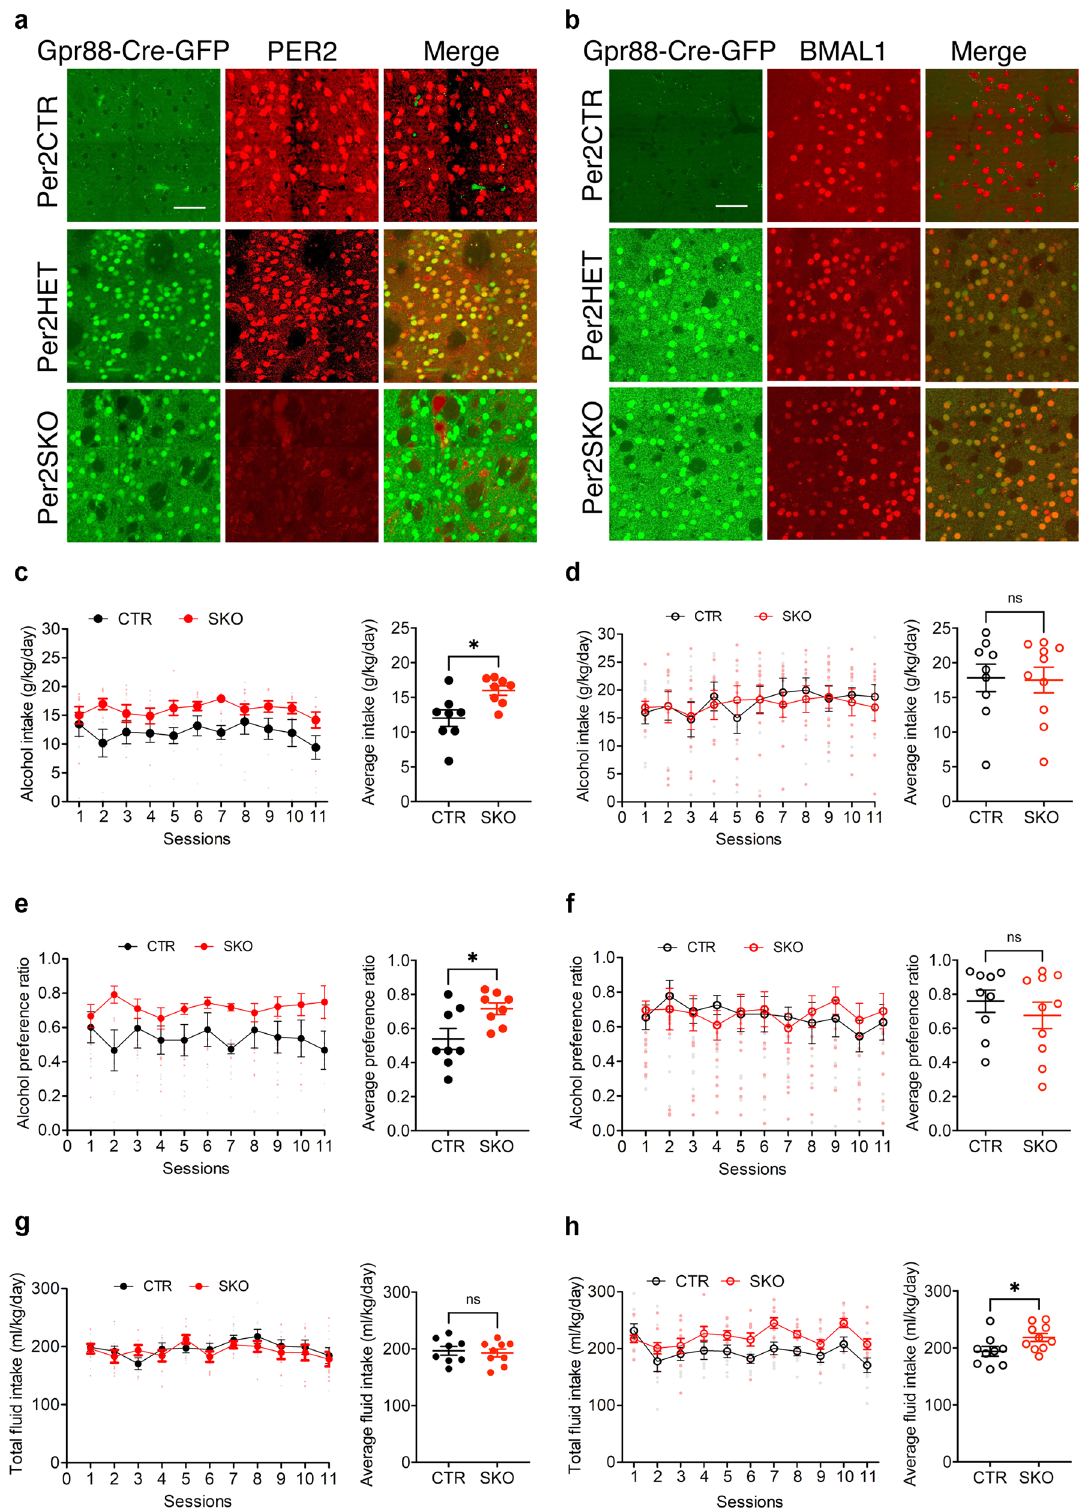
males and females, Bmal1HET show no difference in alcohol consumption compared to control animals (Fig. 3a – f and Supplementary Data 3), indicating that one copy of Bmal1 in MSNs is suf fi cient to maintain the normal level of alcohol consumption. Total fl uid intake (Fig. 1i, j) and body weight (Supplementary Fig. 1e – h, Supplementary Data 1) were com- parable between genotypes in both sexes, establishing that